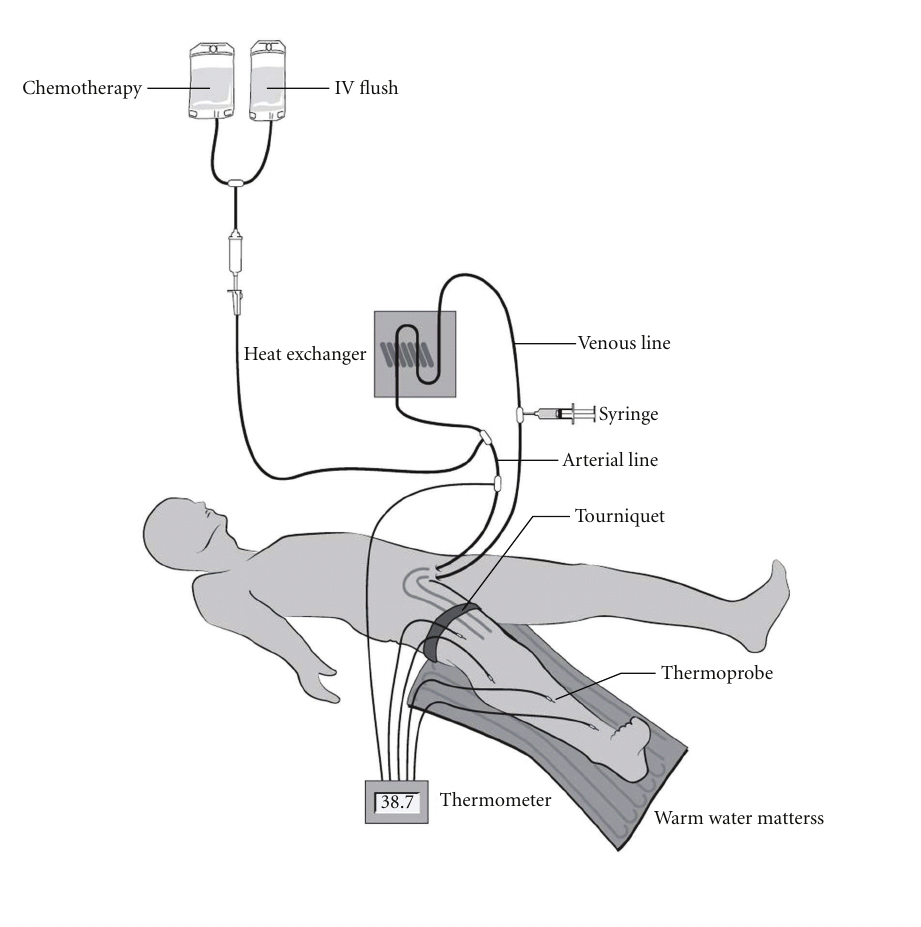
Figure 1: Schematic illustration of the circuit used for isolated infusion of a lower limb [15].